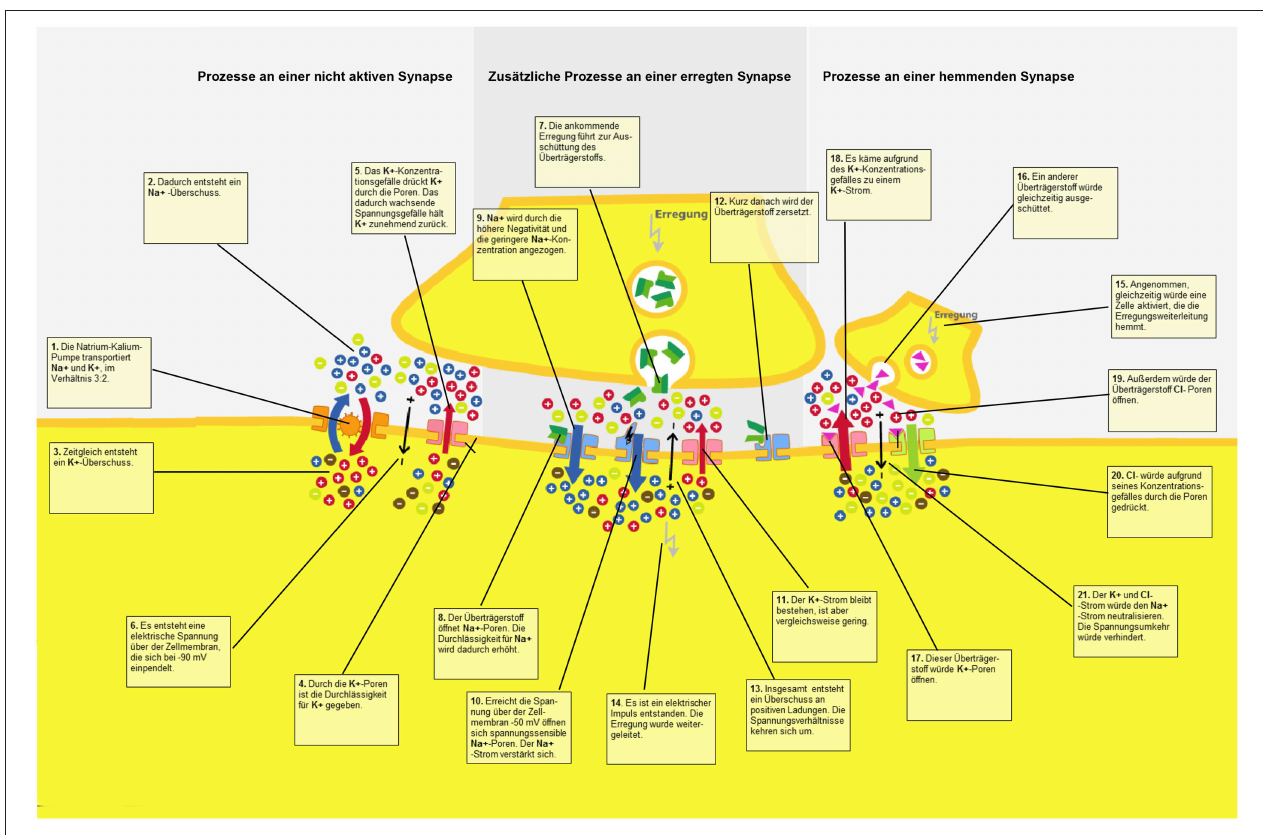
FIGURE 5 | Integrated text-picture presentation with low spatial proximity in Experiment 1.